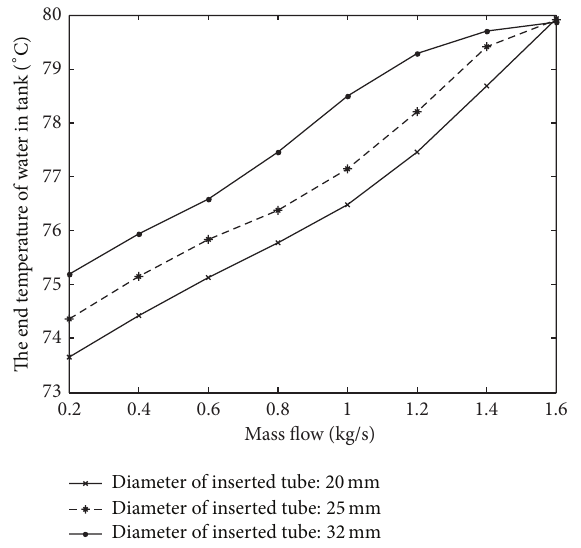
Figure 12: Water tank temperature versus mass flow rate under different inserted tube outer